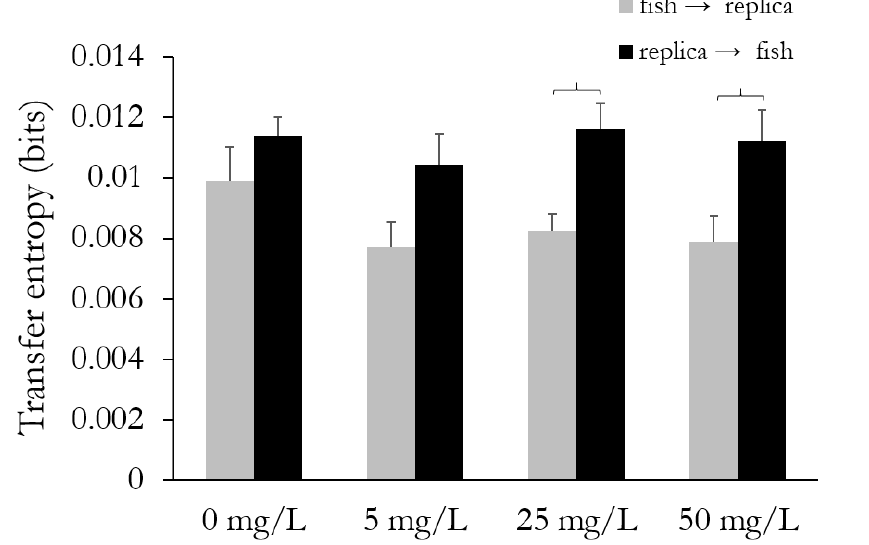
Figure 10 . Transfer entropy for experiments on the interaction between live zebrafish treated with caffeine and a shoal of life-sized replicas maneuvered by a robotic arm along pre-programmed trajectories. Experiments refer to four conditions at caffeine concentrations: 0, 5, 25, and 50 mg/L. Error bars represent ± standard errors and curly braces indicate statistically significant differences. [Reproduced from (Ladu, Mwaffo, et al.,